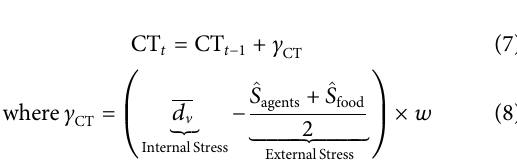
FIGURE4 | An overview of thehormonalmechanisms modelled in theAffective(Hormonal) System ofouragent model. OT =Oxytocin. CT= Cortisol. θ ST = Stress Tolerance. Number in parentheses is the equation(s) that correspond to our modelling of speci fi c effects. * = Effect accounted for in our second experiment only. Descriptions of these effects are seen in this section, and summarised in Table 2